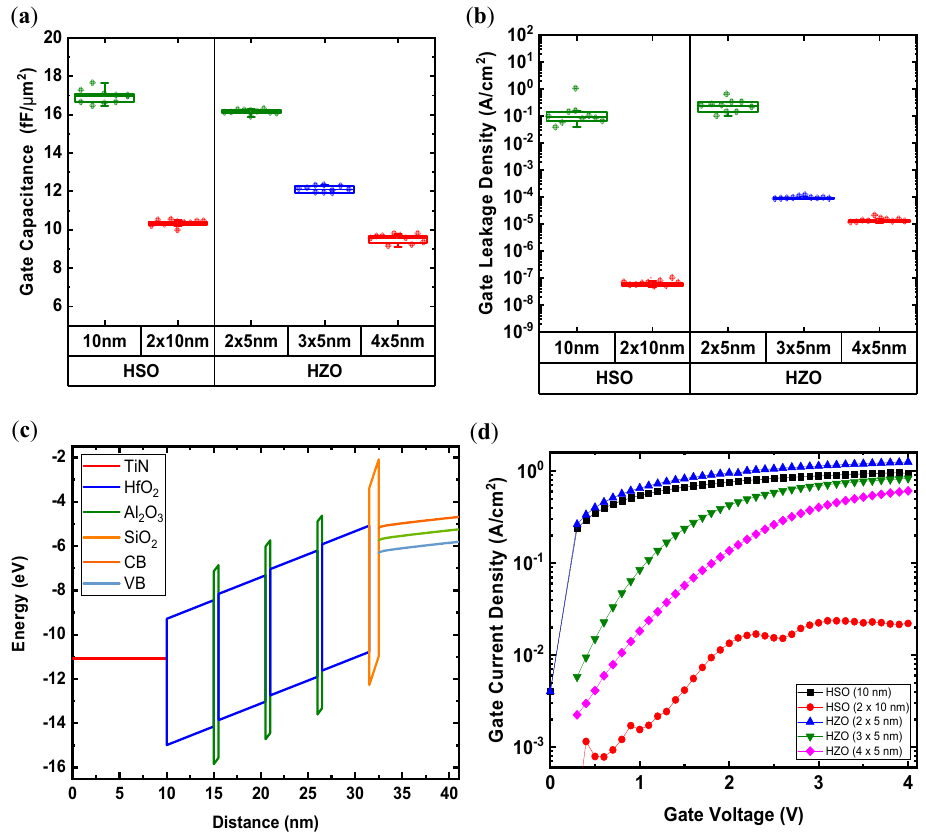
Figure 6. The laminate FeFET gate stack characteristics as ( a ) capacitance per unit area in accumu- lation obtained from the high-frequency capacitance–voltage measurements and ( b ) leakage current density obtained from the DC gate current versus gate voltage sweep, ( a , b ) shows the role of stack structure type and thickness, ( c ) the energy band diagram of the laminated ferroelectric stack (4 × 5 nm) under PG conditions at 6 V, ( d ) gate leakage current density for voltage sweep (0 V to 4 V) benchmarking the different single and FE laminate stacks. ( a , b ) Reproduced with permission from [17] T. Ali et al., IEDM; published by IEEE, Copyright 2019,